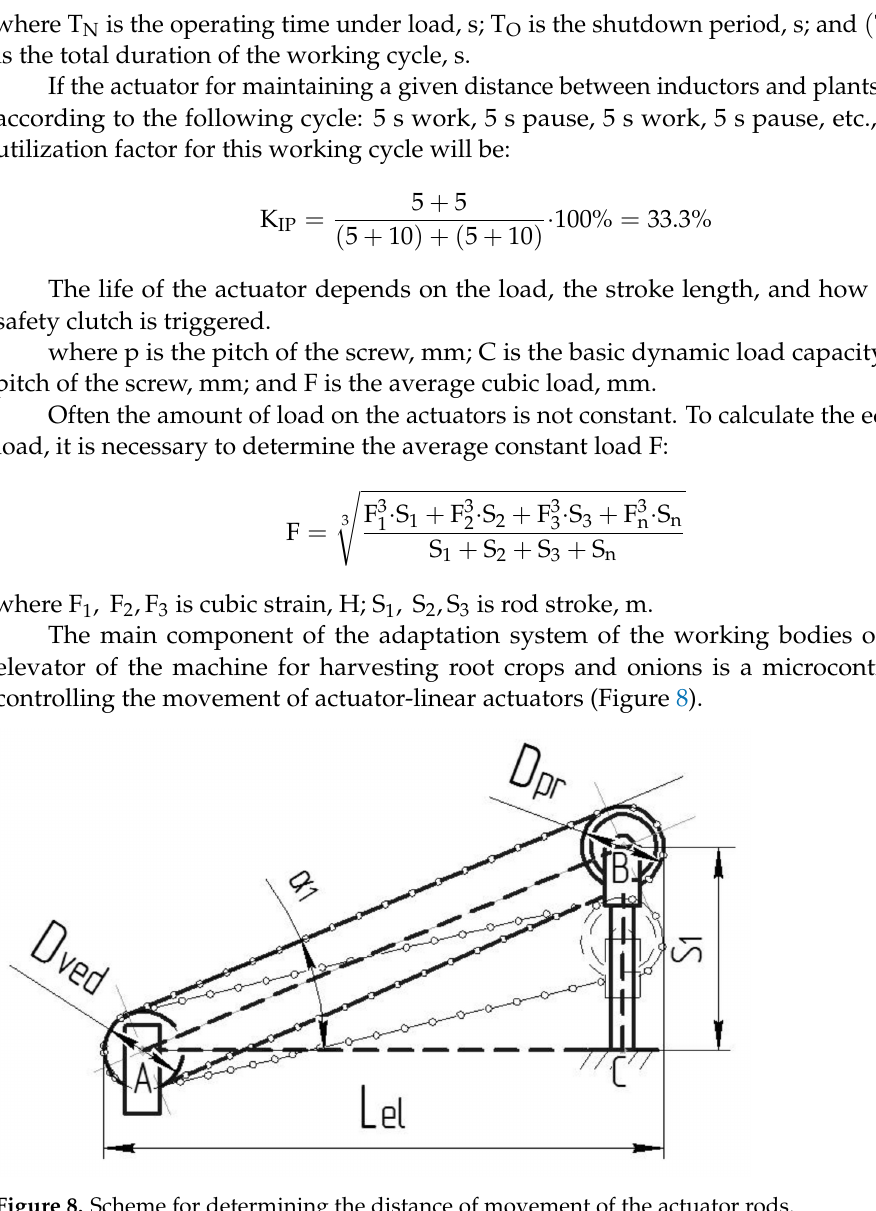
Figure 8. Scheme for determining the distance of movement of the actuator